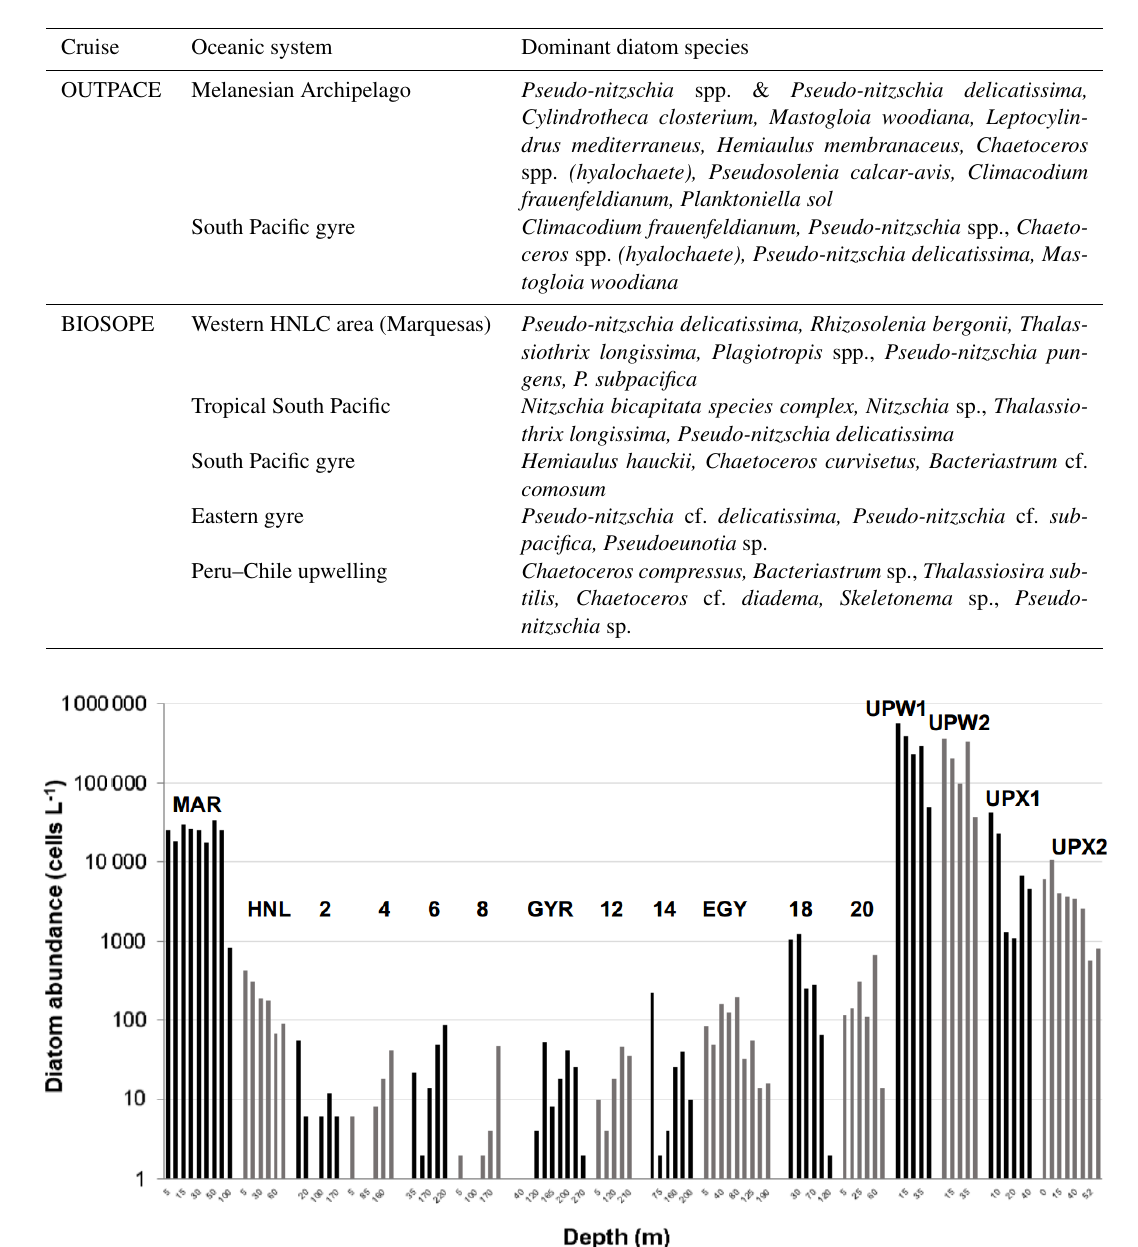
Table 2. Dominant diatom species in each main system of the BIOSOPE and OUTPACE cruises. Taxonomic information for the OUTPACE cruise was derived from discrete samplings at the surface and DCM and phytoplankton nets, while information for the BIOSOPE cruise was obtained through an average of six discrete samples over the euphotic layer (see Gomez et al., 2007).